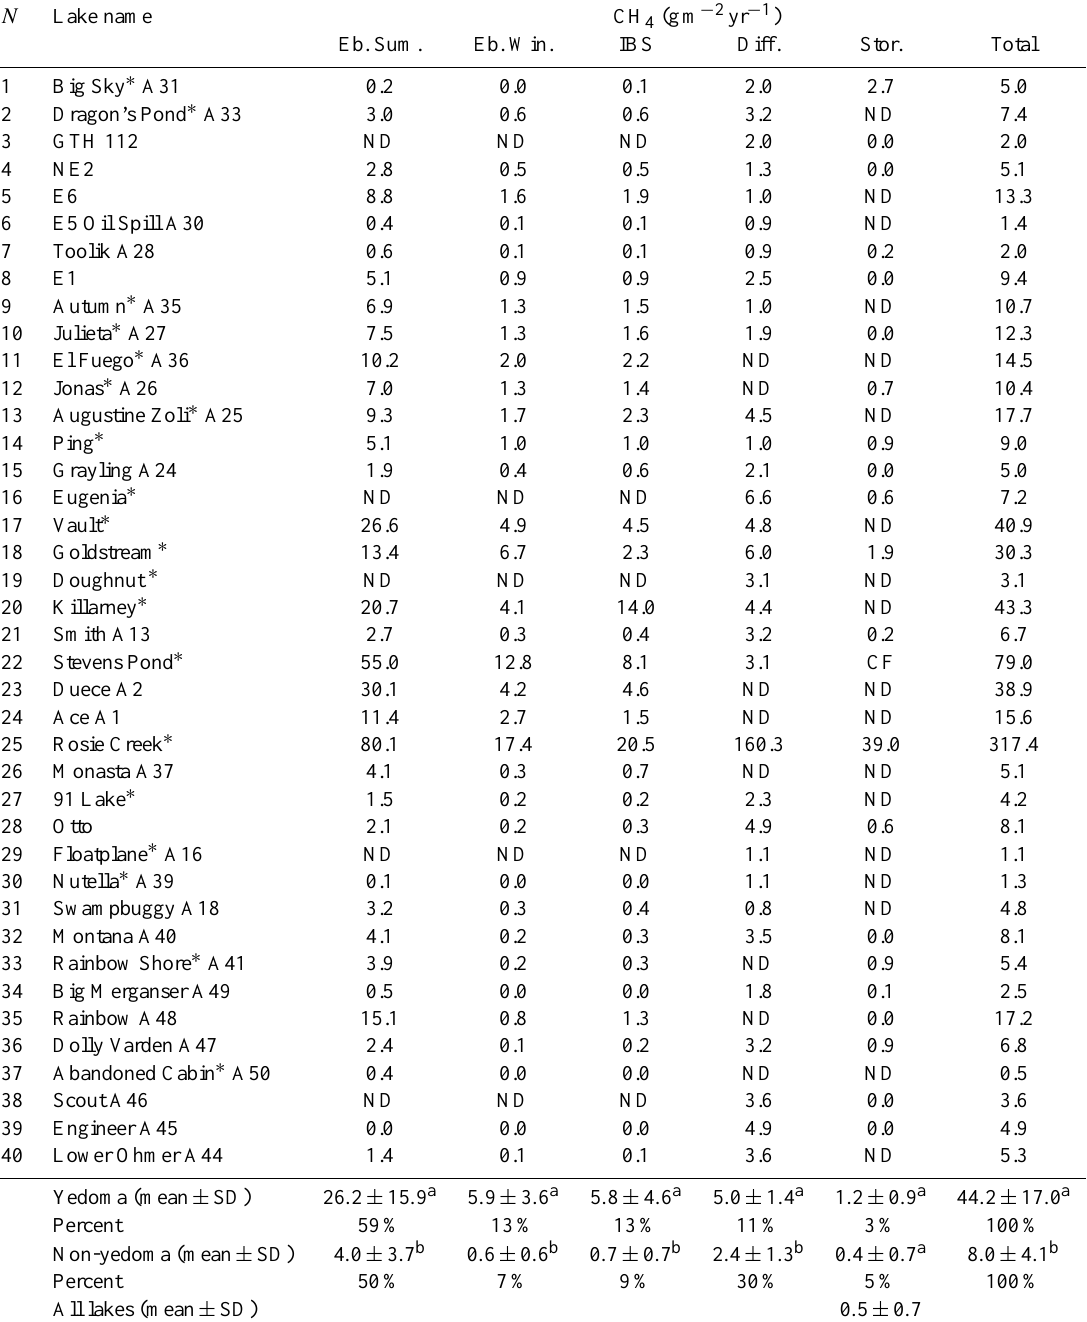
Table 2. Total annual CH 4 and CO 2 emissions by mode from 40 lakes along a north–south latitudinal transect in Alaska. ∗ indicates informal lake names. Eb. Sum. – direct ebullition emission to the atmosphere from seeps during the ice-free summer season; Eb. Win. – direct ebullition emission to the atmosphere from seeps during the ice-cover winter season; IBS – ice-bubble storage during spring ice melt; Stor. – storage emission following ice-out; Diff. – diffusive emission in summer; Total – total annual emissions. If there was ND (no determination) for one or more modes in a lake, then total annual emission for the lake is likely an underestimate. Average emissions are summarized at the bottom of the table, as is the percent of total annual emissions contributed by each mode as well as statistical results for differences in means among yedoma and non-yedoma lakes (Mann–Whitney test). Error terms represent standard deviation; N is the individual lake number and CF indicates impossible determination due to lake ice completely freezing to the lake bed in winter. CO 2 diffusive flux from lakes #17 and #18 were estimated from samples taken on multiple dates in June and July 2013 since no data were available in 2011–2012. Different letters a,b indicate a significant difference between yedoma and non-yedoma